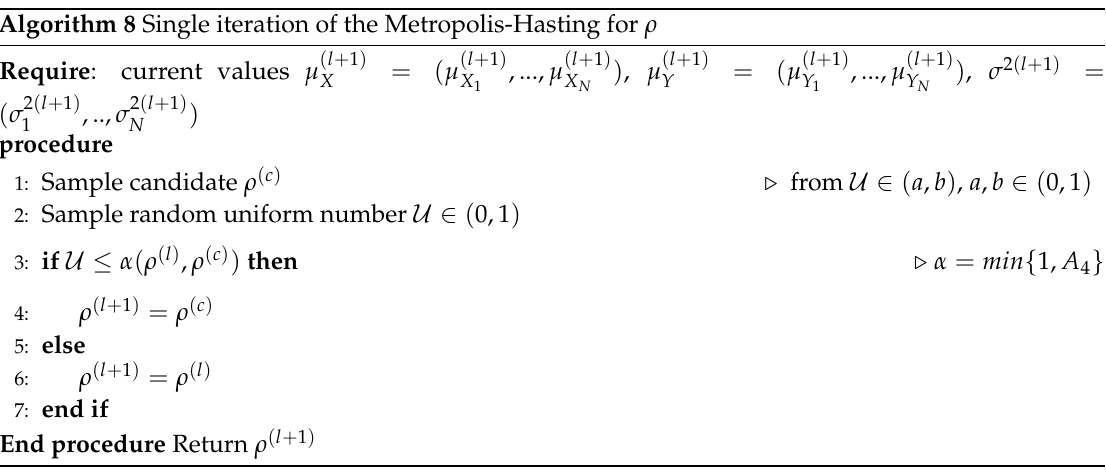
Algorithm 8 Single iteration of the Metropolis-Hasting for